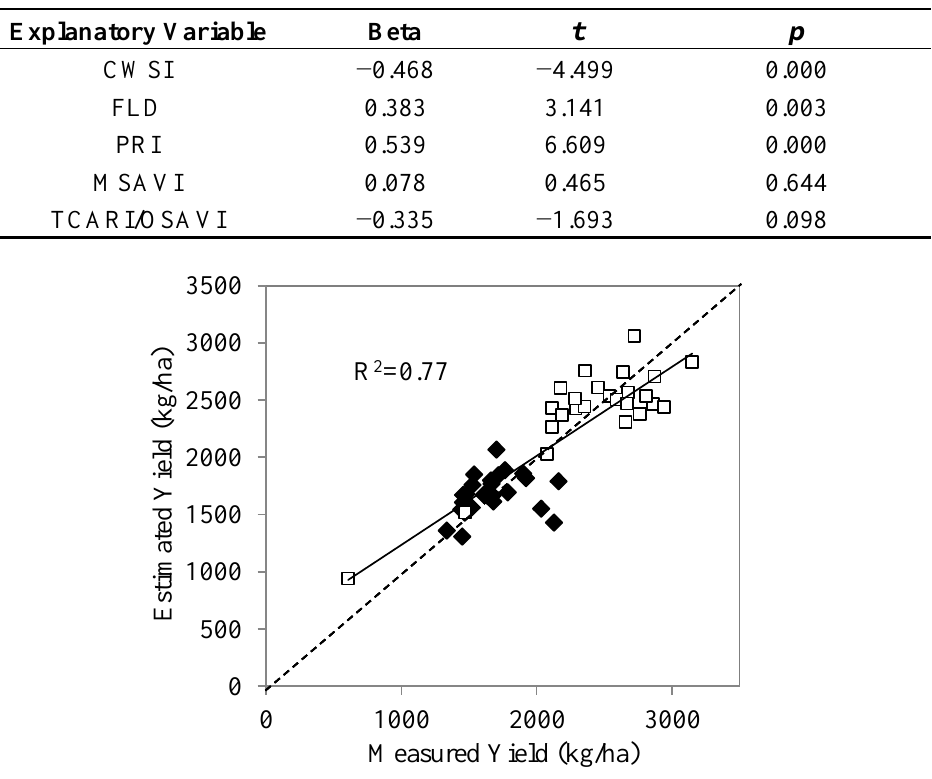
Figure 9. Comparison of measured yield and the estimation derived from the multiple regression, with CWSI, FLD, and PRI as independent variables. The adjusted regression and the calculation of the RMSE include both durum (solid symbols) and bread wheat (open